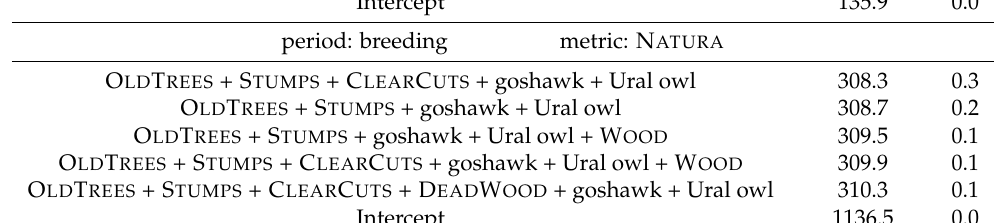
Figure 3. Correspondence Canonical Analysis plots showing the ordination of bird species winter- ing (above) or breeding (below) in examined plots along the first two axes and their correlation with occurrence of goshawks (AG), Ural owls (SU) and control plots, as well as selected environmental variables (W OOD — deciduous vs. coniferous, O LD T REES — number of veteran trees, D EAD W OOD — number of large snags and logs, C LEAR C UTS — area of clear − cuts and S TUMPS — number of fresh stumps). The arrows represent the environmental variables selected, and the dots represent the bird species. The direction of the arrows indicates their correlation with an axis or a particular species. The length of the arrow represents the size of the effect, the longer the arrow the stronger the rela- tionship of that variable with the community.